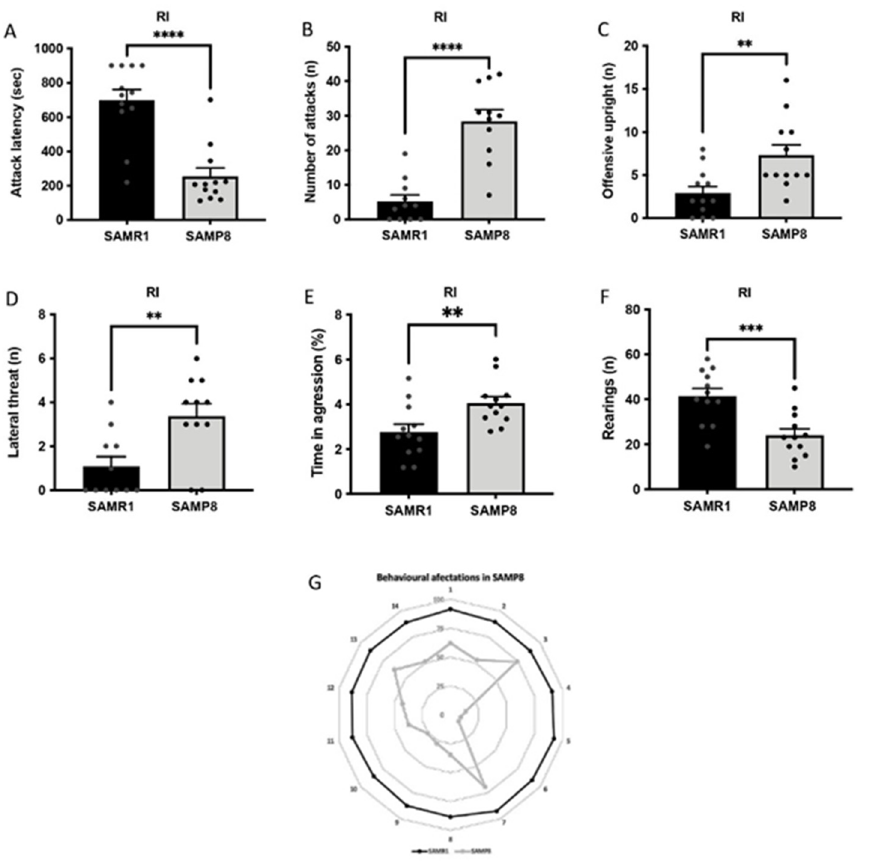
Figure 2. Results of the resident–intruder test (RI) in male SAMR1 and SAMP8 mice at 12 months of age. Attack latency ( A ), number of attacks ( B ), number of offensive uprights ( C ), number of lateral threats ( D ), time in aggression ( E ) and number of rearings ( F ). Bars show the mean ± SEM (For RI: n = 11–12 mice per group). Statistical test: t-Student analysis. ** p < 0.01; *** p < 0.001; **** p < 0.0001. Polygonal graph presenting a summary of the relevant behavioural parameters ( G ).